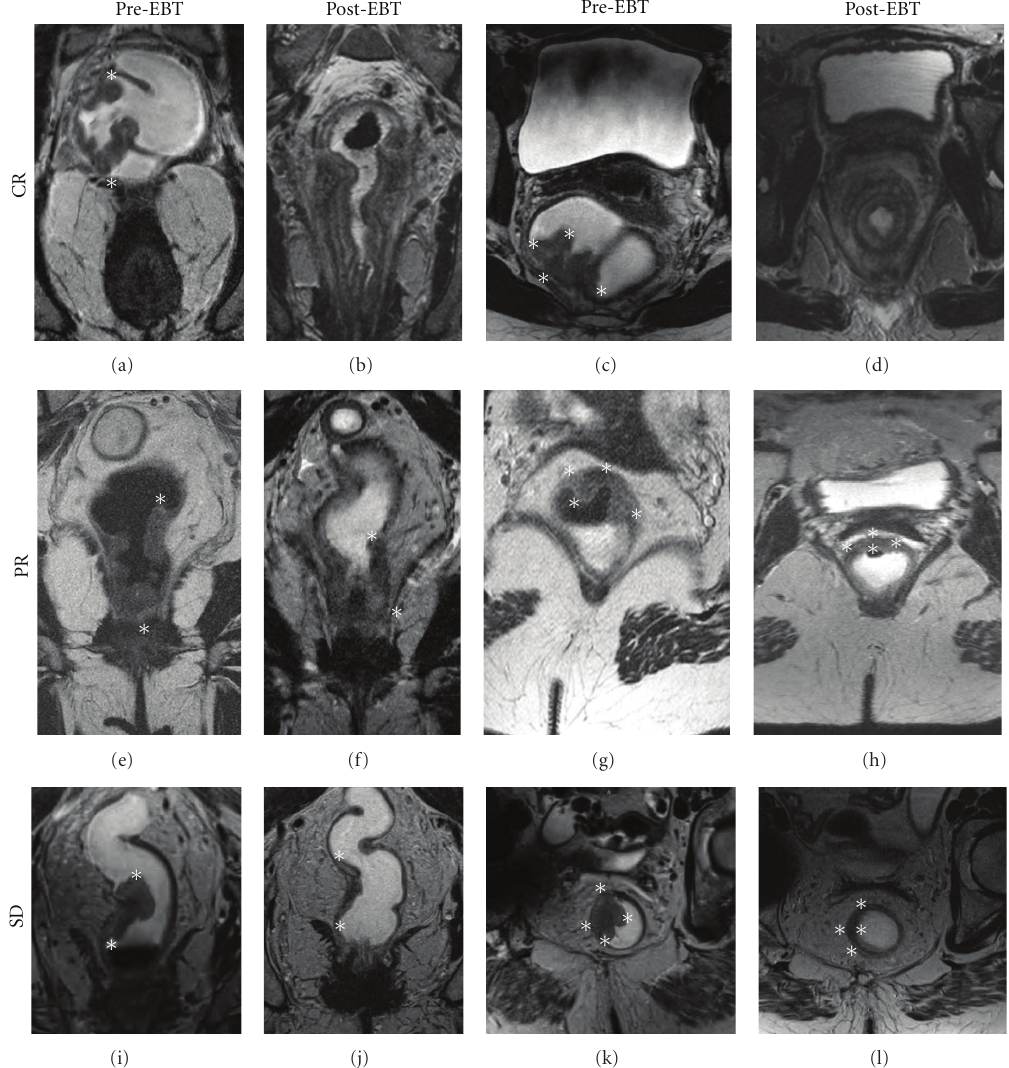
Figure 2: Representative pre- and posttreatment MRI slices from patients who underwent EBT and were found to have a complete pathologic response (pCR: defined as no residual tumor on histopathologic examination) at surgery. Although all 3 patients achieved a complete pathologic response, they demonstrated di ff ering degrees of radiologic response on MRI according to RECIST, suggesting that degree of radiologic response does not necessarily predict for degree of pathologic tumor response. The longest tumor dimensions in 3 planes used for RECIST assessment are indicated by white asterisks. Scans represented in the top, middle, and bottom rows were obtained 39, 34, and 32 days following the completion of radiotherapy, respectively. Top row: coronal (a), (b) and axial (c), (d) MRI slices from a patient with a pCR who also demonstrated a radiologic complete response (CR); no residual tumor is visualized on post-EBT MRI (b), (d). Middle row: coronal (e), (f) and axial (g), (h) MRI slices from a patient with a pCR who demonstrated a radiologic partial response (PR) on post-EBT MRI (f), (h). Bottom row: coronal (i), (j) and axial (k), (l) MRI slices from a patient with pCR who demonstrated stable disease (SD) on post-EBT MRI (j),